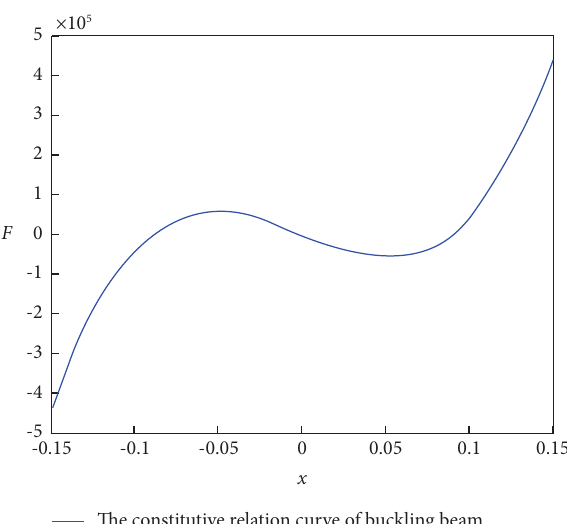
Figure 3: Force and displacement curve of buckling